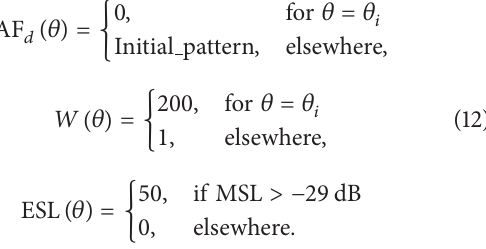
Table 4: The amplitude values calculated by DS for the antenna arrays with 12, 16, and 20 elements.